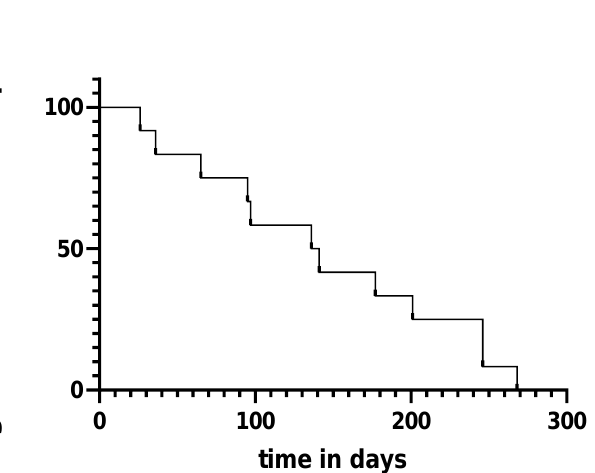
Figure 1. Progression-free survival (all patients).